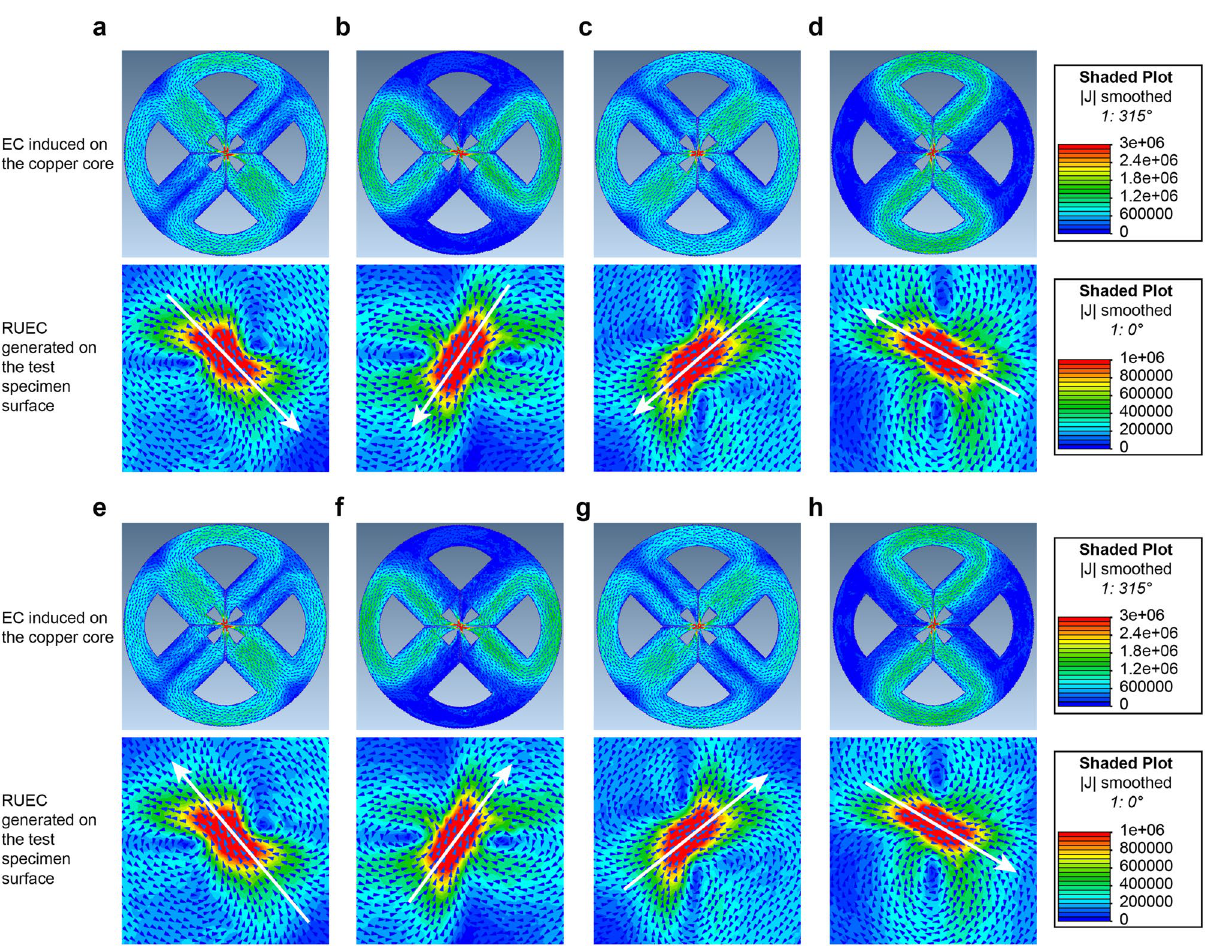
Figure 5. Simulation results of RUEC distribution patterns with the RUECC probe. ( a ) At 0°. ( b ) At 45° (π/4). ( c ) At 90° (π/2). ( d ) At 135° (3π/4). ( e ) At 180° (π). ( f ) At 225° (5π/4). ( g ) At 270° (3π/2). ( h ) At 315°